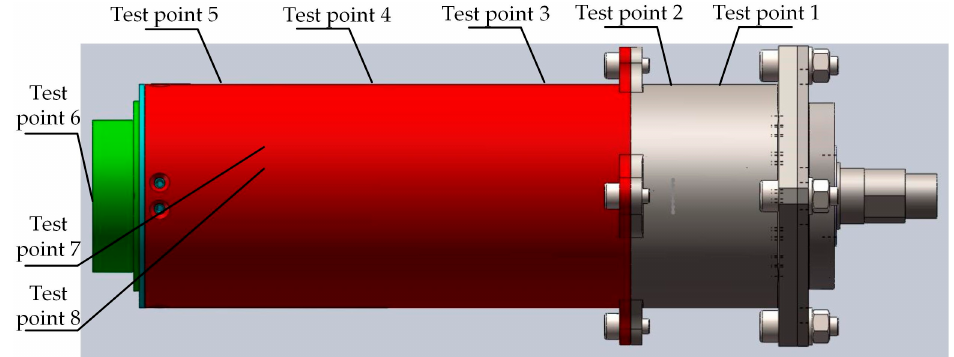
Figure 8. The locations of every test sensor.